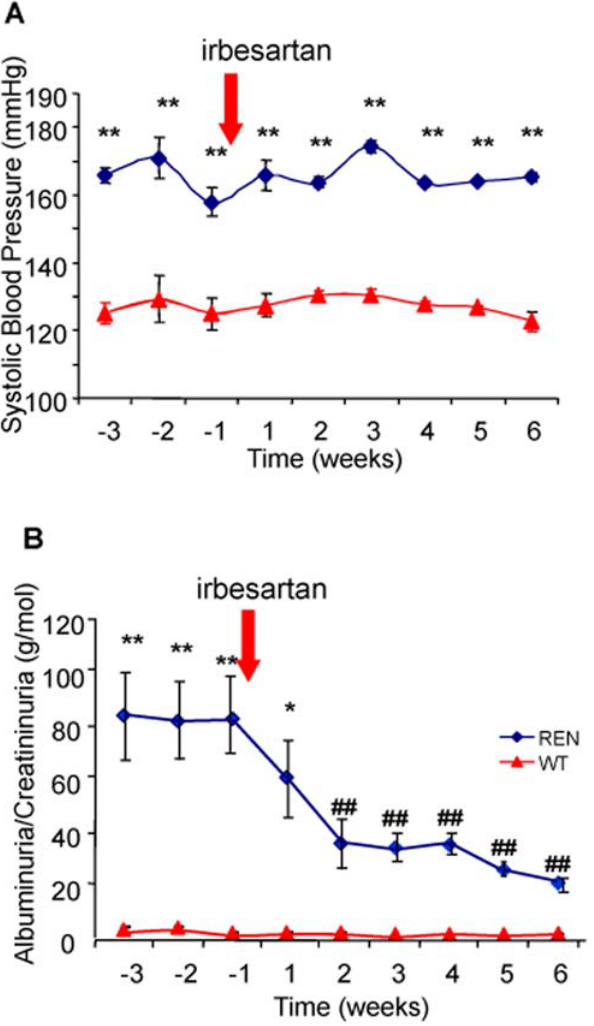
Figure 1. Effect of AT1 receptor antagonism on blood pressure and albuminuria. Systolic blood pressure remained unchanged whereas albuminuria decreased to almost normal levels in 12 month old RenTg mice during administration of the AT1 receptor antagonist irbesartan; in triangles are shown the values for age-matched wild type controls. Values are mean 6 SEM; n=5, 9 and 13 for wild type and RenTg mice before and after irbesartan, respectively; * P , 0,05 or ** P , 0,01 vs WT; ## P , 0,001 vs